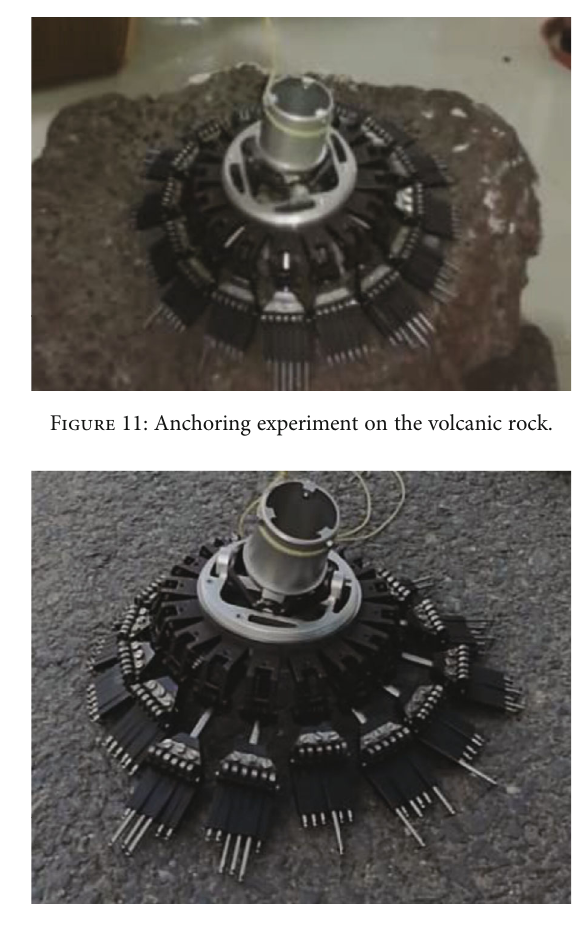
Figure 12: Anchoring experiment on the concrete slab